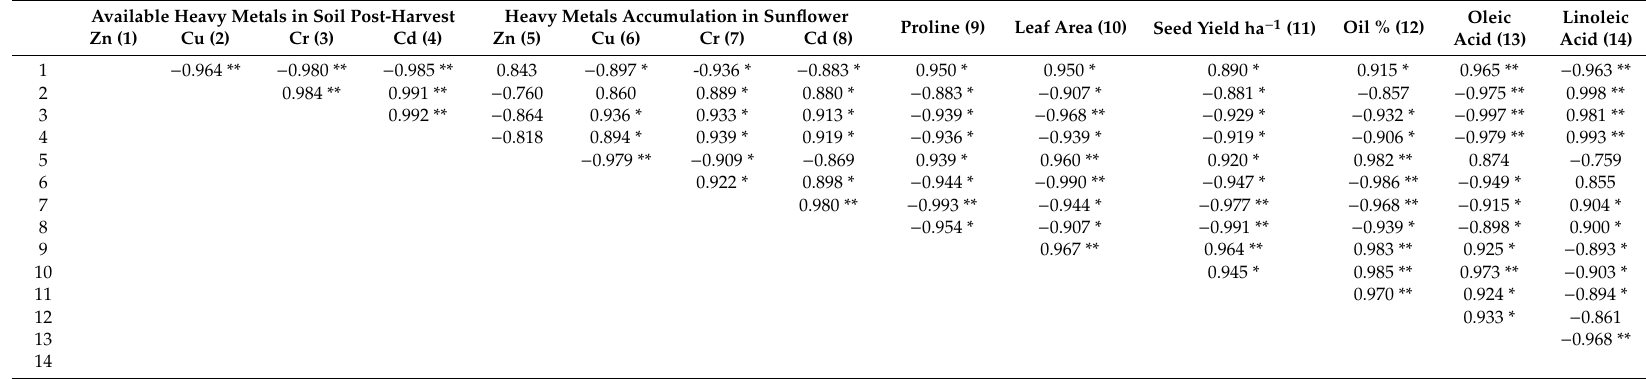
Table 4. Simple correlation coe ffi cient (r) between available heavy metals in soil at harvest, heavy metals accumulation in sunflower, seed yield, growth, and quality traits (overall treatments) as an average of the two